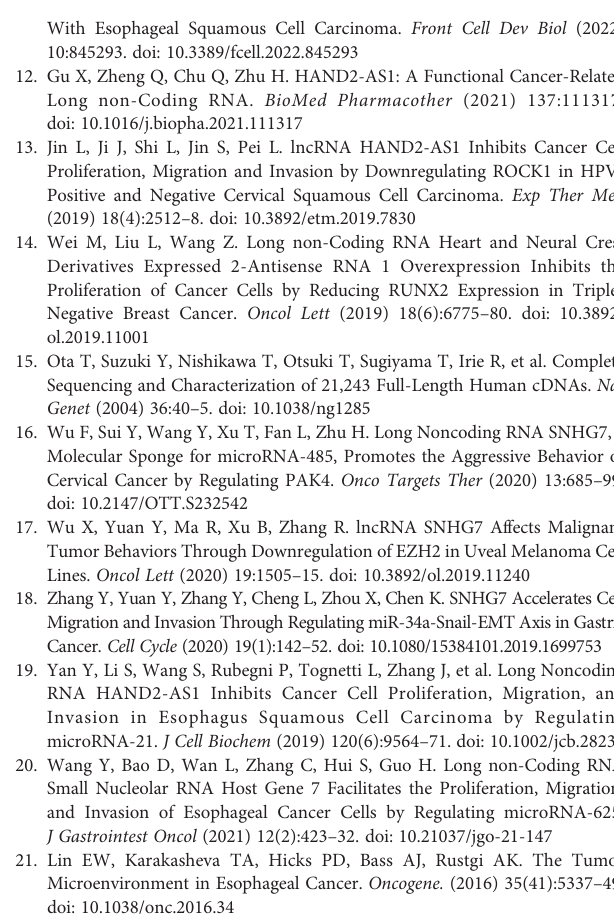
Supplementary Figure 1 | The overall work fl ow of the current study. Supplementary Figure 2 | Correlation of the high-/low-risk subgroups with different clinical characteristics. The heatmap showed associations between the expression of the 7 m7G-related lncRNAs in the low- and high-risk group and clinicopathological features in the GEO cohort (A) and TCGA cohort (B) . * P < 0.05, ** P < 0.01. Supplementary Figure 3 | The KEGG signaling pathways in different risk